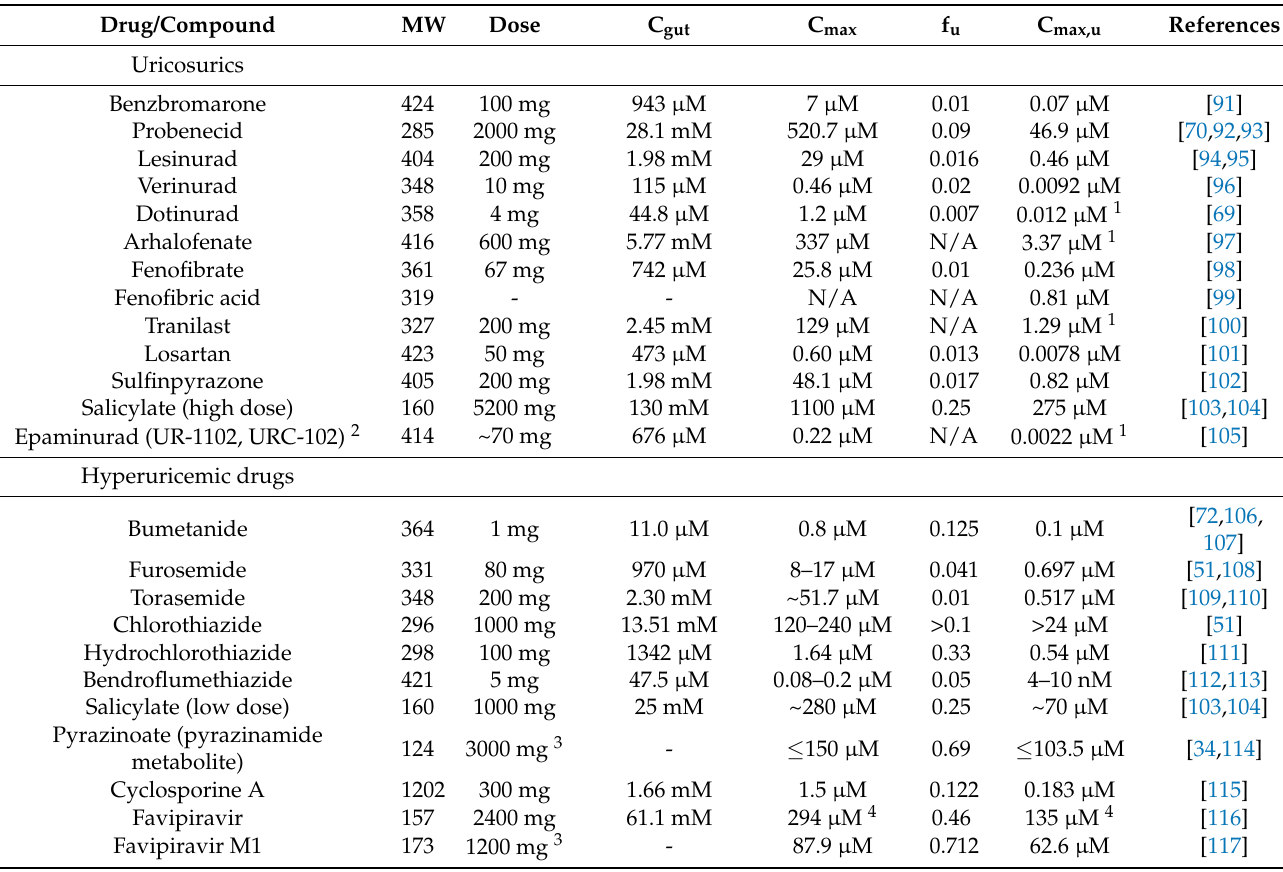
Table 2. Pharmacokinetic properties of uricosurics and hyperuricemic drugs discussed in this review. N/A, not available. 1 Assuming f u = 0.01 (if f u is not available, or the measured f u is <0.01). 3 Refers to the parent compound. 4 Steady-state trough concentration.